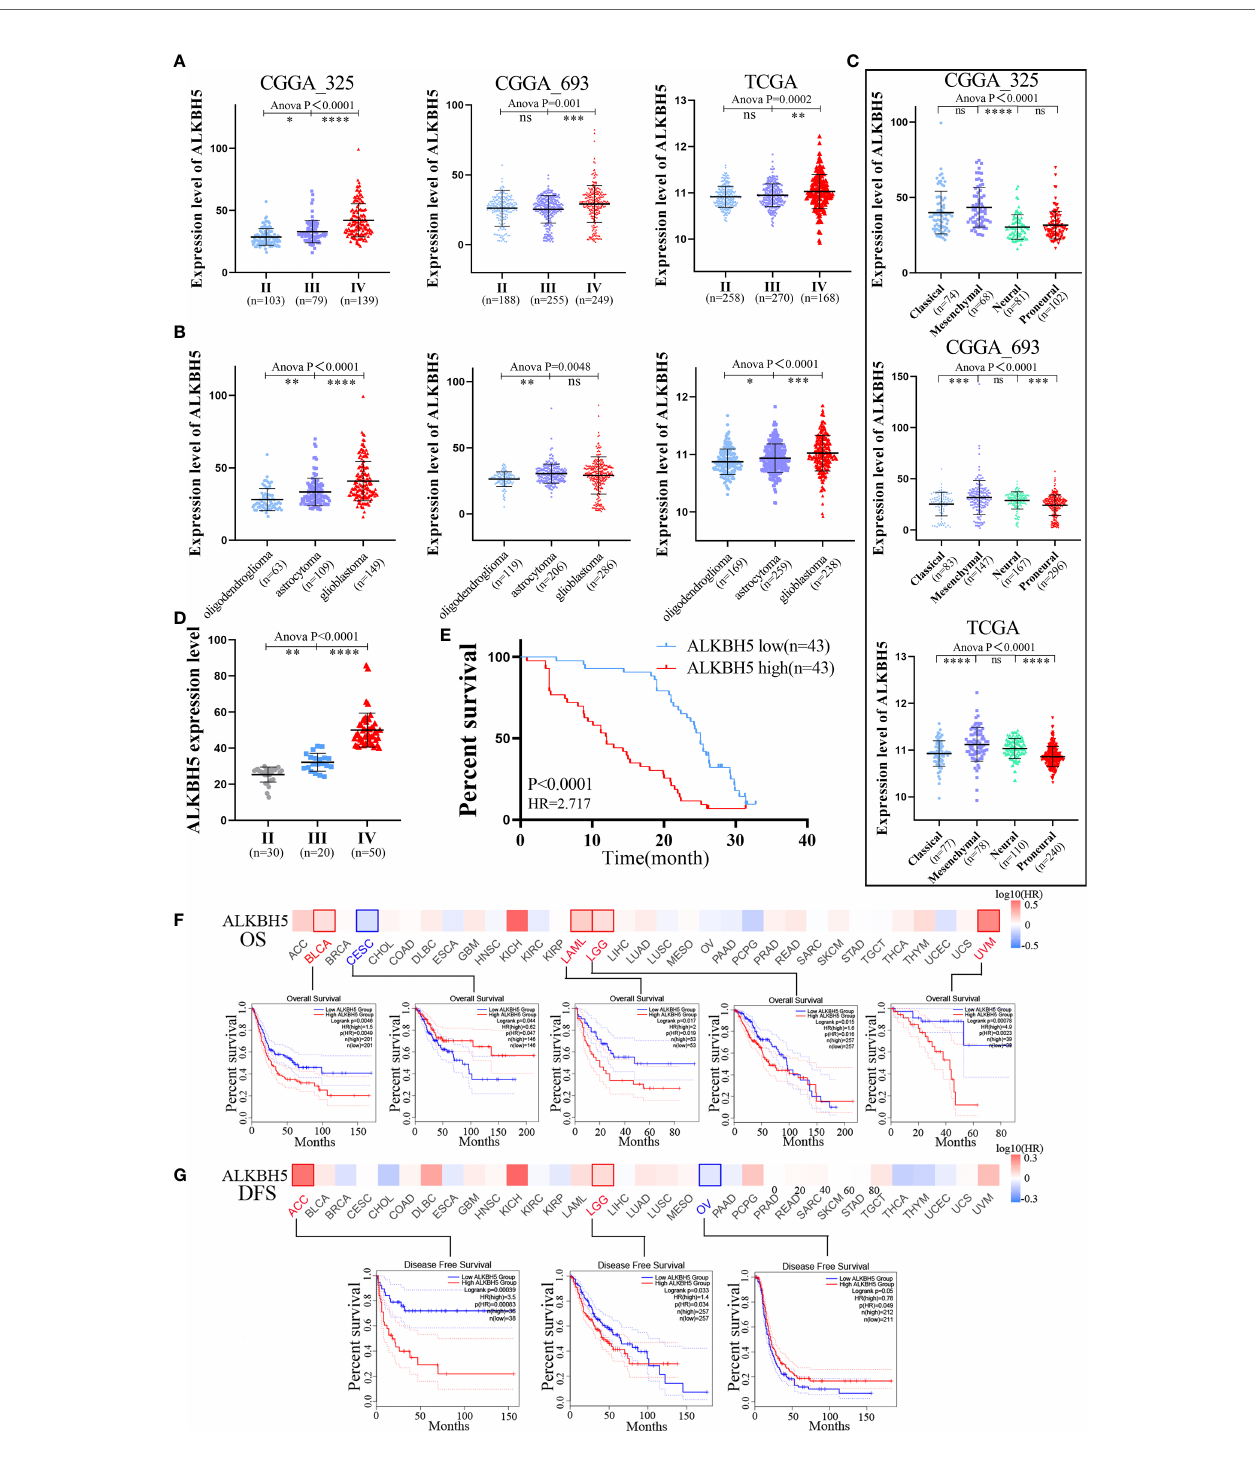
FIGURE 2 | Clinical and molecular characteristics of ALKBH5 in pan-cancer, including gliomas. (A) The correlation between ALKBH5 expression and glioma WHO grade (II, II and IV) in CGGA_325, CGGA_693 and TCGA datasets; (B) The correlation between ALKBH5 expression and glioma three types (oligodendroglioma, astrocytoma and glioblastoma) in CGGA_325, CGGA_693 and TCGA datasets; (C) The relationship between ALKBH5 expression and glioma subtypes (classical, mesenchymal, neural, and proneural) in CGGA_325, CGGA_693 and TCGA datasets; (D) The correlation between ALKBH5 expression and grades in 100 glioma samples, including grade II (n=30), grade III(n=20) and grade IV (n=50) samples; (E) Overall survival (OS) of different ALKBH5 expression level in 100 glioma samples. The GEPIA2 tool was used to perform OS (F) and disease-free survival (DFS) (G) analyses of different tumors in TCGA by ALKBH5 expression. Red label indicated positively correlated, blue label indicated negatively correlated. * P <0.05, ** P <0.01, *** P <0.001, **** P